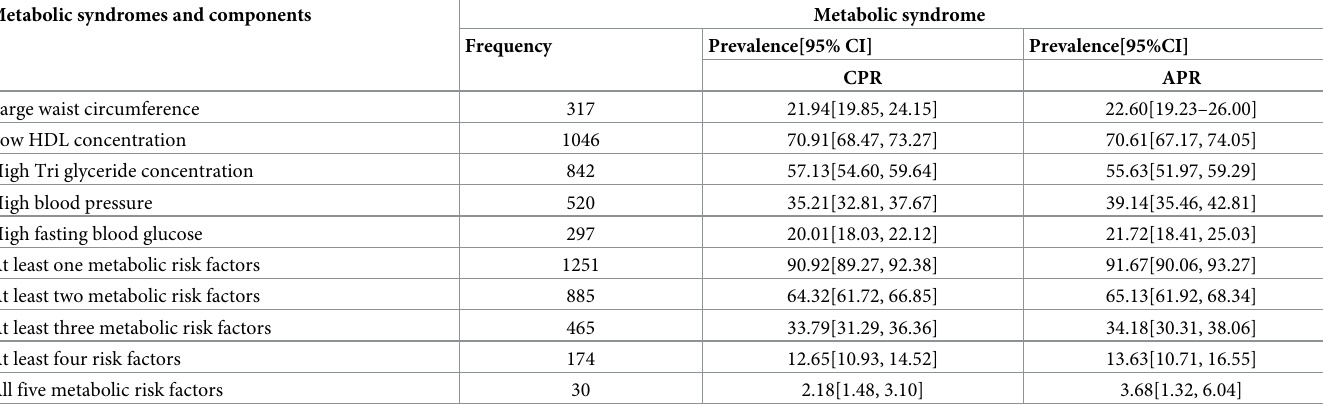
Table 2. Prevalence of metabolic components and syndromes in Northern Ethiopia (n =